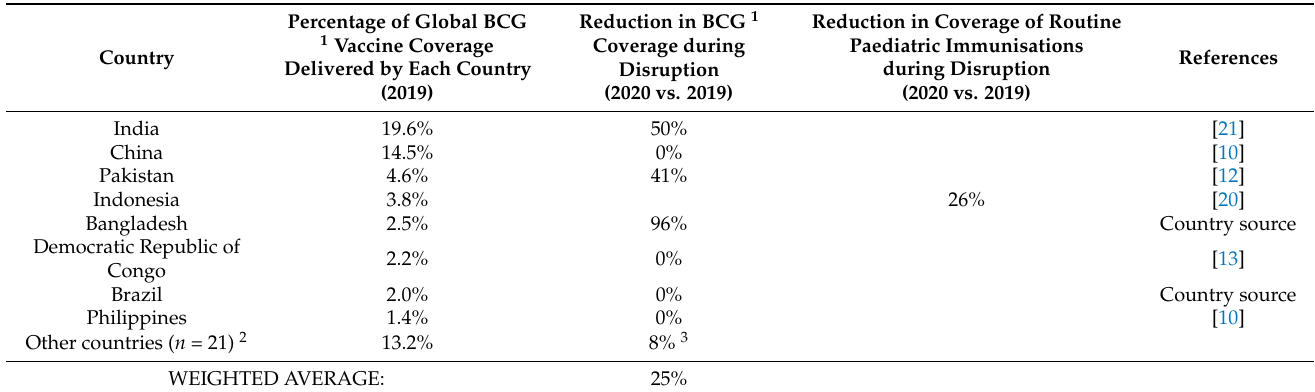
Table 3. Summary of data gathered on global BCG disruption in 2020 due to COVID-19 ( n = 29 countries).